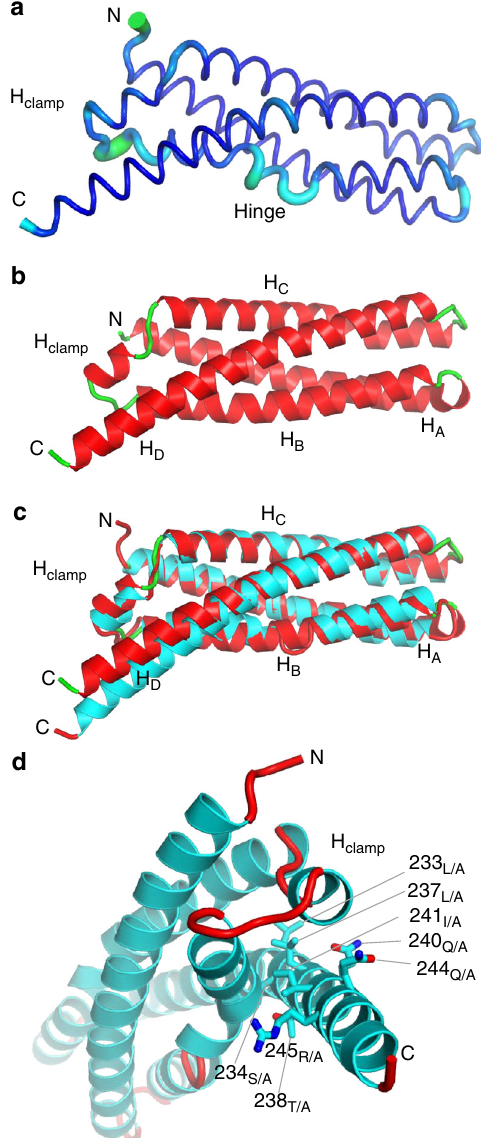
Fig. 2 Analysis of the conformational fl exibility of IncA 87 – 246 reveals two features. a Graphic representation of IncA 87 – 246 anisotropically re fi ned B-factor plotted onto the 3D-structure: the diameter of the tube is proportional to the B-factor. The hinge region and the moiety C-terminal of the H clamp (in cyan) deviate by more than two standard deviations from the mean B-factor. b Crystal structure of IncA 87 – 246(G144A) (protomer A), re fi ned at 1.95 Å resolution (Table 1) with α -helices and random coiled linkers colored in red and green, respectively. c Secondary structure superimposition of IncA 87 – 246(G144A) (green and red) with IncA 87 – 246 (red and cyan). d Magni fi ed view of IncA 87 – 246 viewed down the main helical axis. Residues mutated to Ala in IncA 87 – 246(polyA) are shown as